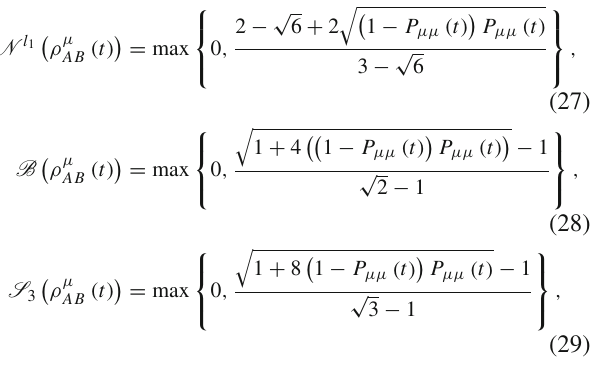
Fig. 3 The quantifiers of NAQC (solid line, red) in Eq. (10), Bell nonlocality (dashed line, blue) in Eq. (12), and Steering (dotted-dashed line, green) in Eq. (14) with respect to the distance traveled per energy L / E for the initial electron flavor state